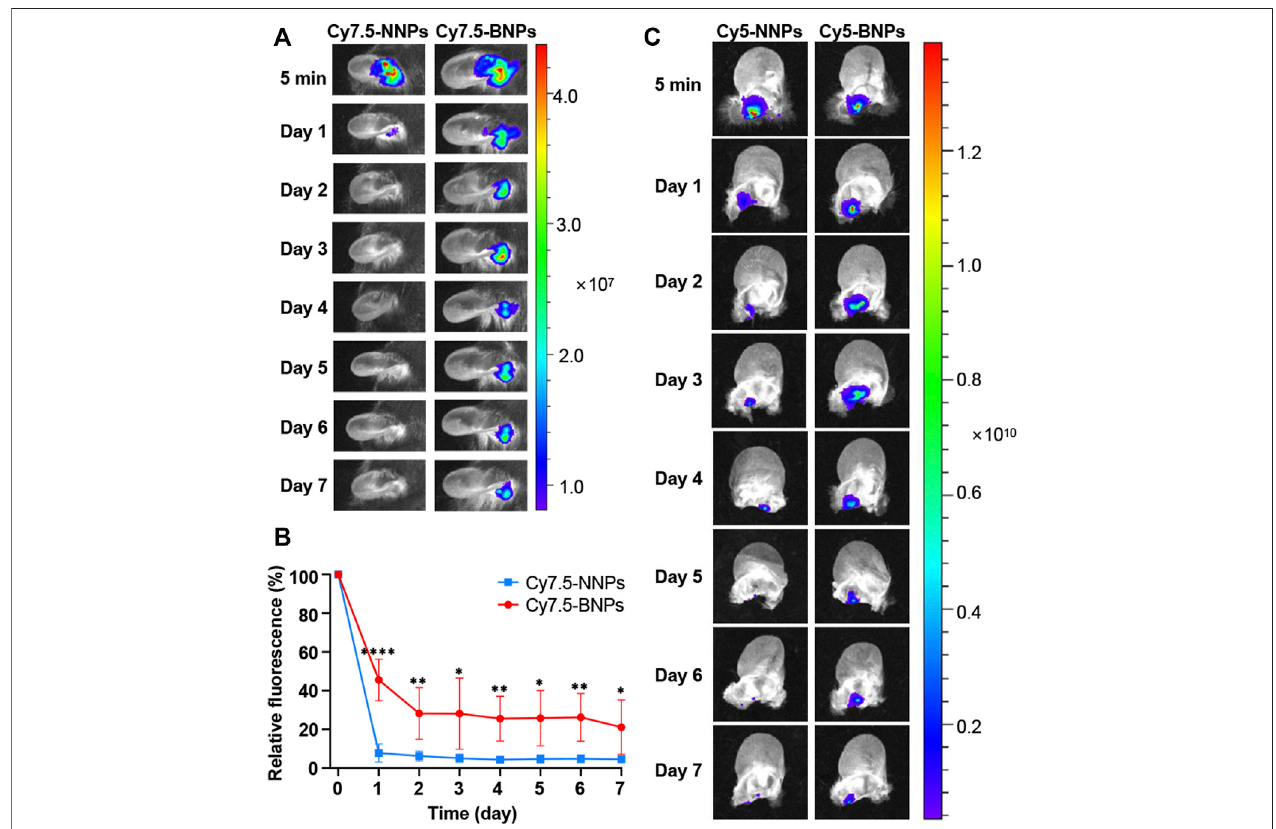
FIGURE 3 | Retention of nanoparticles in the middle ear. (A) The retention of the Cy7.5-NNPs and Cy7.5-BNPs monitored with NIR imaging after administration in vivo .Scalebarrepresentsrelativedyeintensity. (B) Quanti fi cationof fl uorescenceretainedinthemiddleearfor7 days.Dataaremeans±SD( n =4).* p < 0.05,** p < 0.01, *** p < 0.001, **** p < 0.001, compared with Cy7.5-NNP group (Student ’ s t-test). (C) Living imaging of harvested middle ear tissue treated with either Cy5-NNPs (left panel) or Cy5-BNPs (right panel) for 7